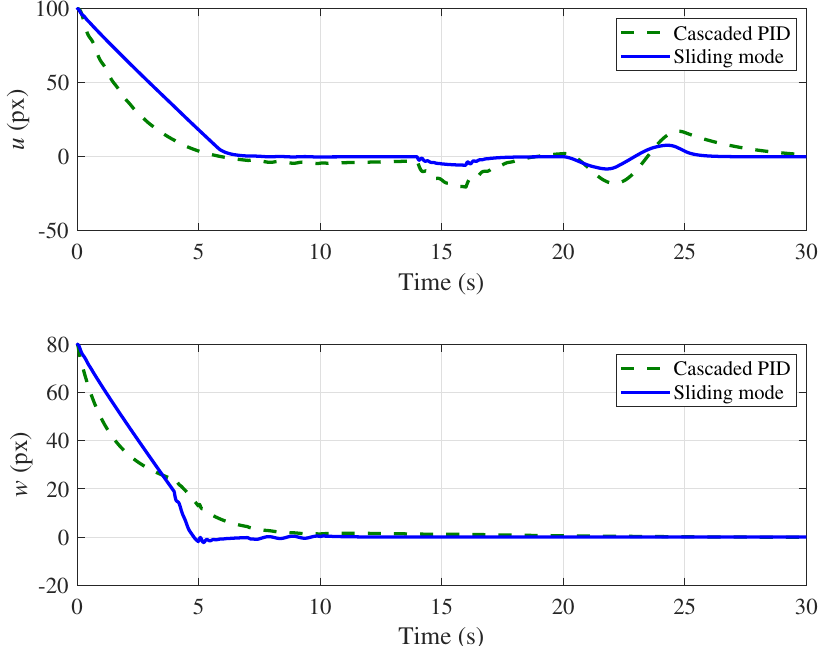
Figure 11. Trajectories of horizontal and vertical tracking errors in numerical simulations.